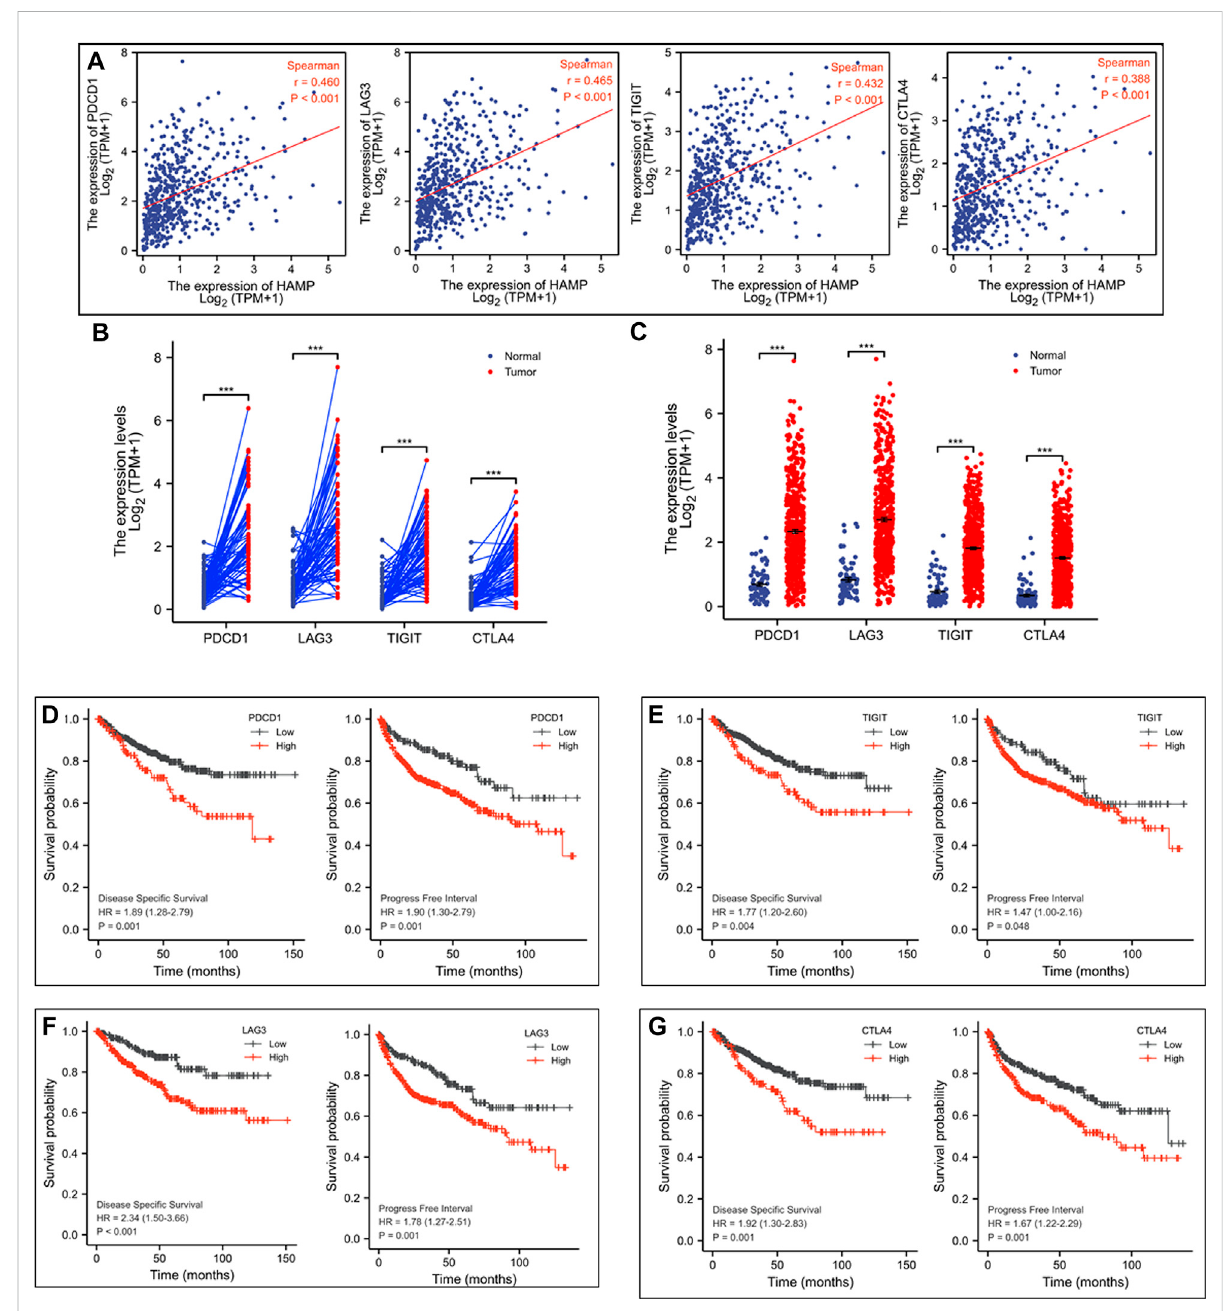
FIGURE 6 HAMP expression is associated with immune checkpoint receptors in ccRCC tissues. (A) Spearman correlation was analyzed between HAMP expression and immune checkpoint genes, and a strong correlation (Spearman r > 0.35) was noticed between HAMP and PDCD1, LAG3, TIGIT, and CTLA4. (B – C) The expression of theimmune checkpointgenes wasanalyzed usingthe TCGA-KIRC dataset inacase-matchedpairwisecomparison (panel B ) orgroup cohort (panel C )The p -valueswerederived from a paired t -testor Wilcoxon rank-sum test. (D – G) Patient survival outcomes of disease-speci fi c and progression-free intervals were analyzed based on individual genes using the Kaplan-Meier curve, as described (Liu et al., 2018). The 95% con fi dence interval of the H.R. value was listed between the parentheses. The p -values were derived from the Log-rank